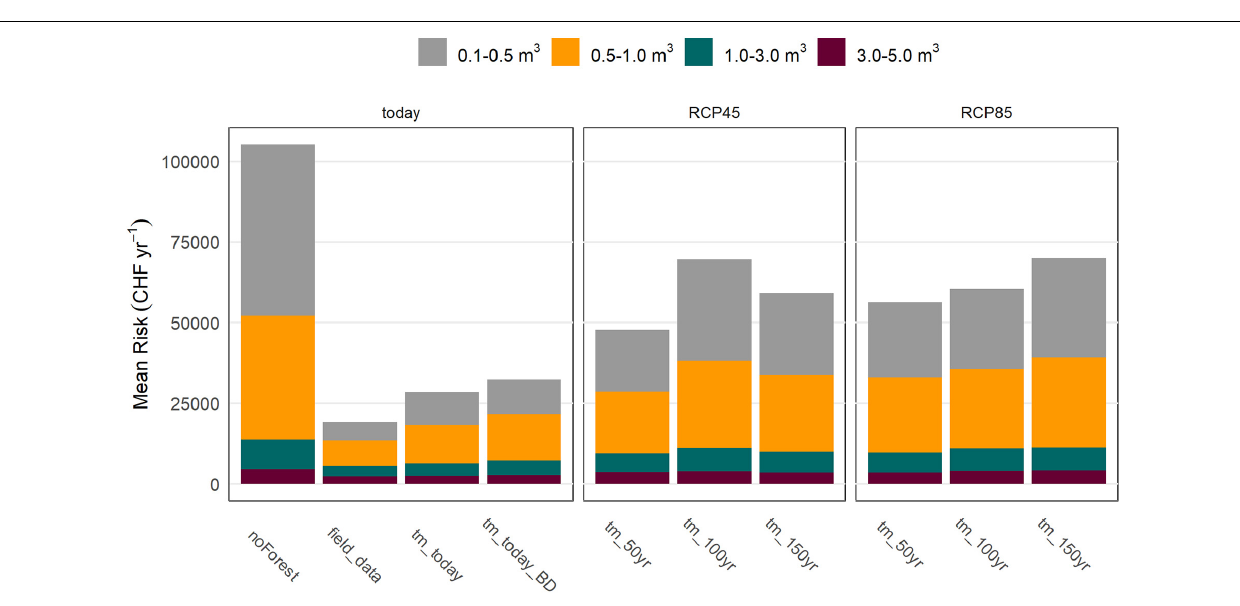
FIGURE 10 | Mean risk for all considered elements at risk for the current forest based on field data ( top ; “field_data”), based on TreeMig simulations (tm) with ( above ; “tm_today_Dist”) and without ( left , “tm_today”) disturbance, and for future forest scenarios in 50 (tm_50yr), 100 (tm_100yr), and 150 years (tm_150yr) under climate scenario RCP4.5 ( middle ) and RCP8.5 ( right ) (only shown with background